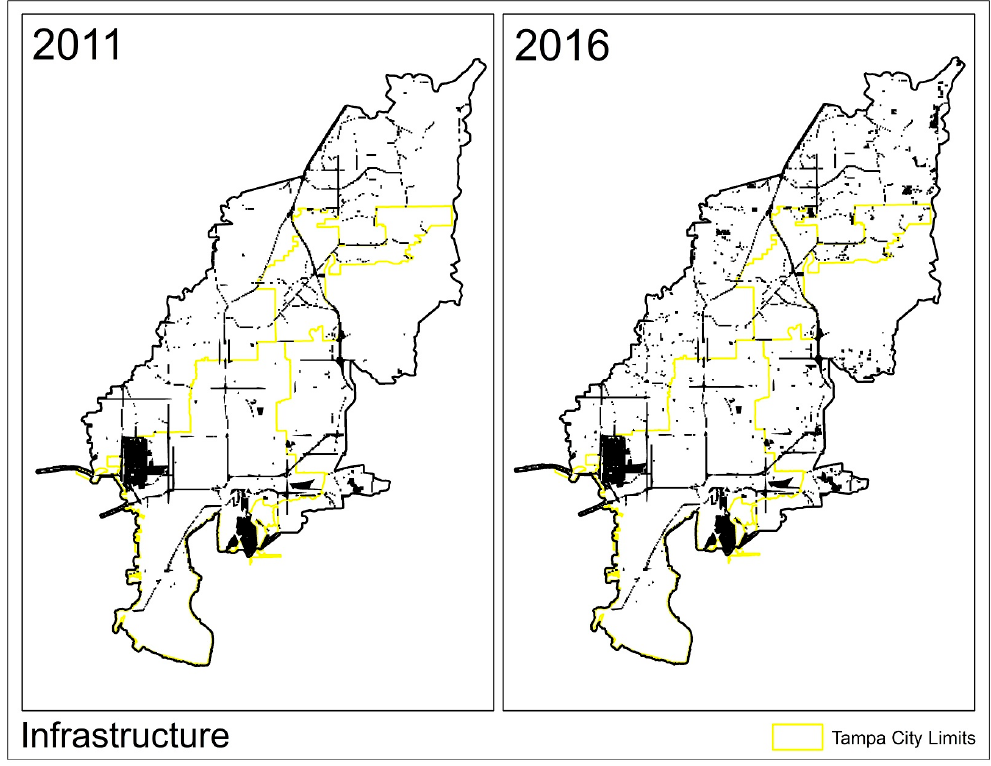
Figure A10. Observed (2011) and Modeled (2016) LULC distribution for the “Infrastructure” class.